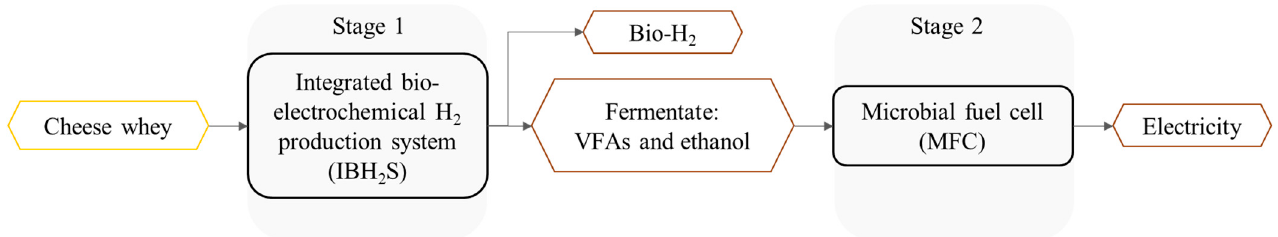
Figure 1. Two-stage process scheme for cheese whey valorization.